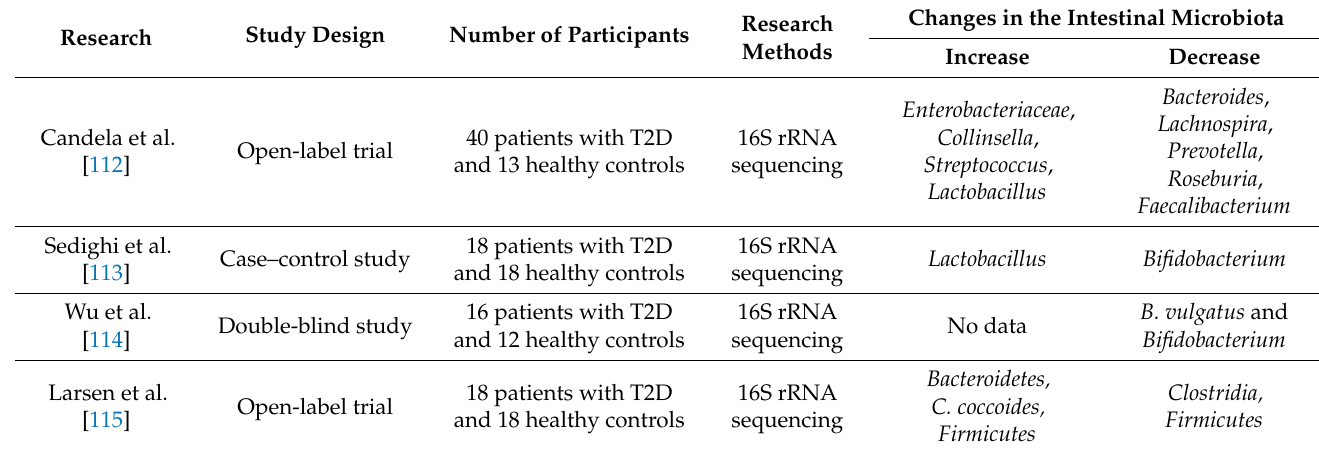
Table 2. Type 2 diabetes and gut microbiota